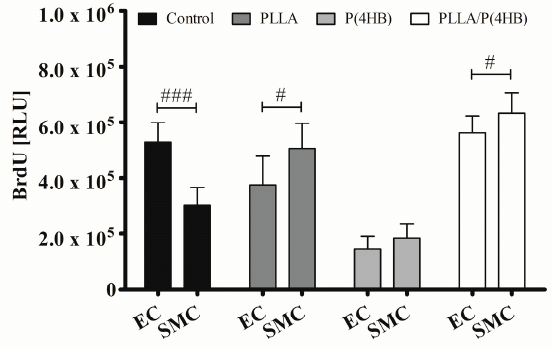
Figure 4. Polymers attenuate cell type-specific anti-proliferative effects of ATOR on vascular cells. HCAEC (EC) and HCASMC (SMC) were cultured on polymer surfaces and treated for 48 h with 0.1 µM ATOR. Proliferation was determined after BrdU incorporation. Bars show mean ± SD of at least five separate experiments with # p < 0.05 and ### p < 0.001.